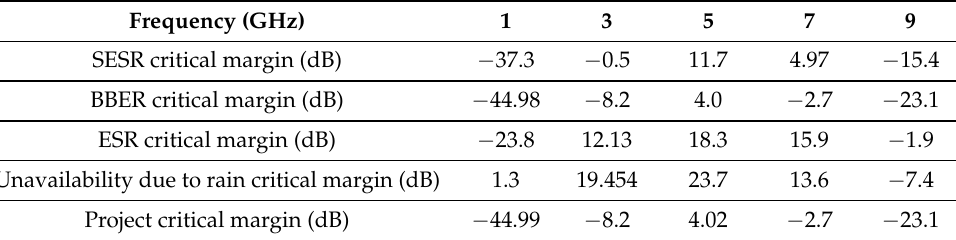
Table 8. The critical margins of project clauses for the simulated terrestrial project using diversity and equalization.